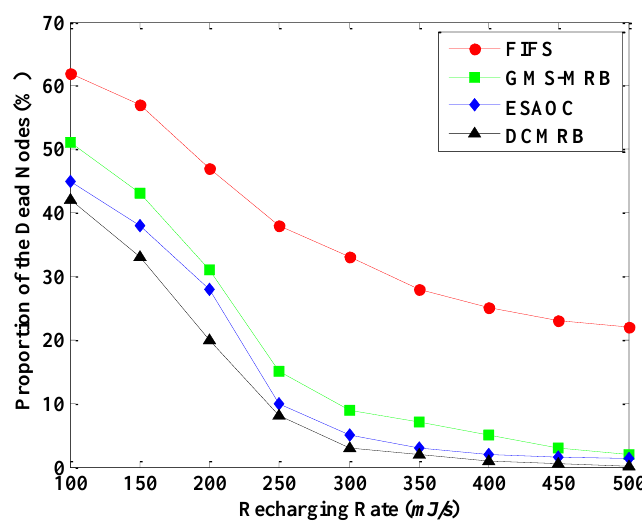
Figure 21. Proportion of the dead nodes under different recharging rates.